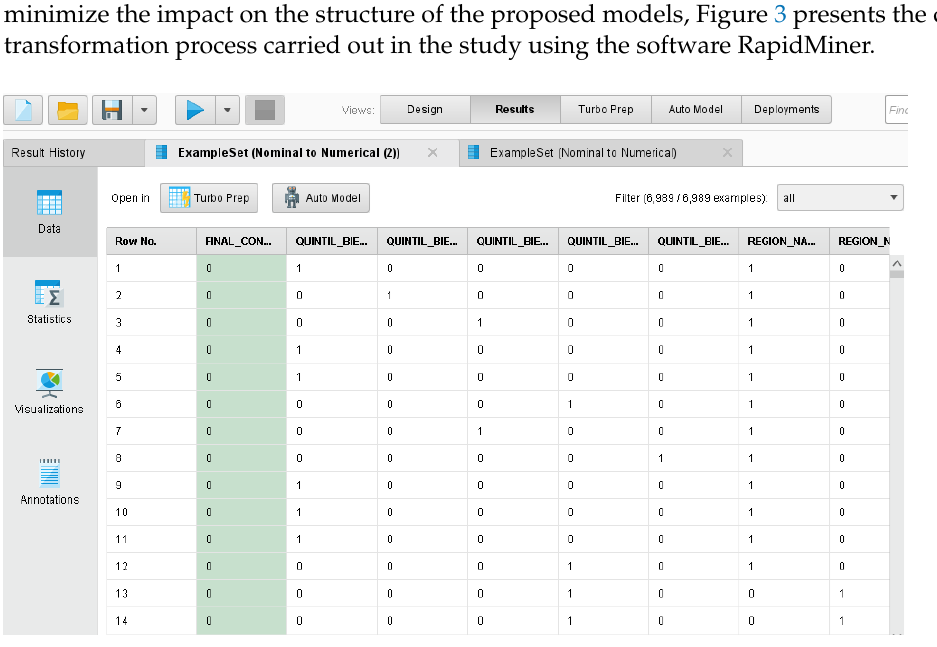
Figure 3. Results of the one-hot encoding conversion of variables in this study through the use of the software RapidMiner and the Nominal to Numerical